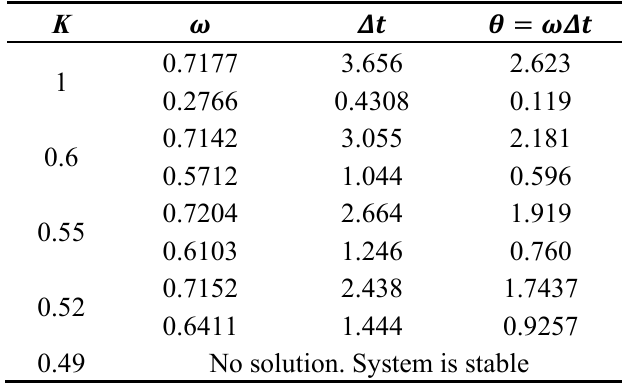
Table 5. The frequency and pulse width of the stable and unstable limit cycles for different values of